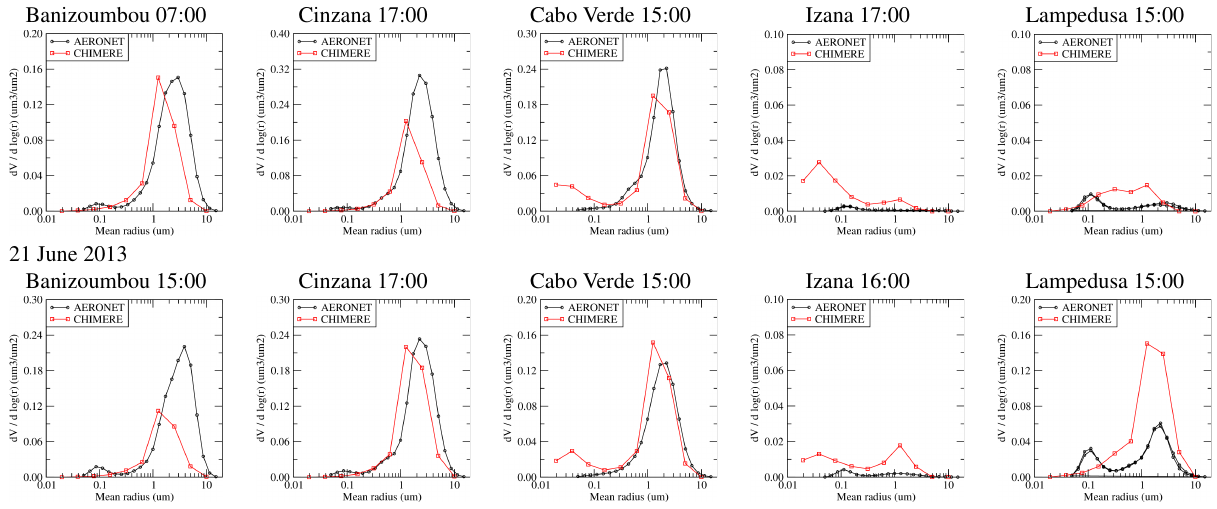
Figure 18. Comparisons between the measured (AERONET) and modeled (CHIMERE) aerosol size distributions for the locations of Ban- izoumbou, Cinzana, Cabo Verde, Izana and Lampedusa. Distributions are presented for 17 and 21 June 2013, and for hours where the AERONET hourly inverted distributions are